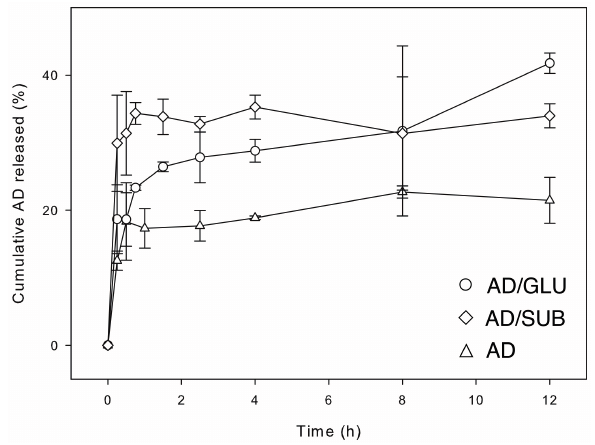
Figure 6. Release behaviors of AD and its